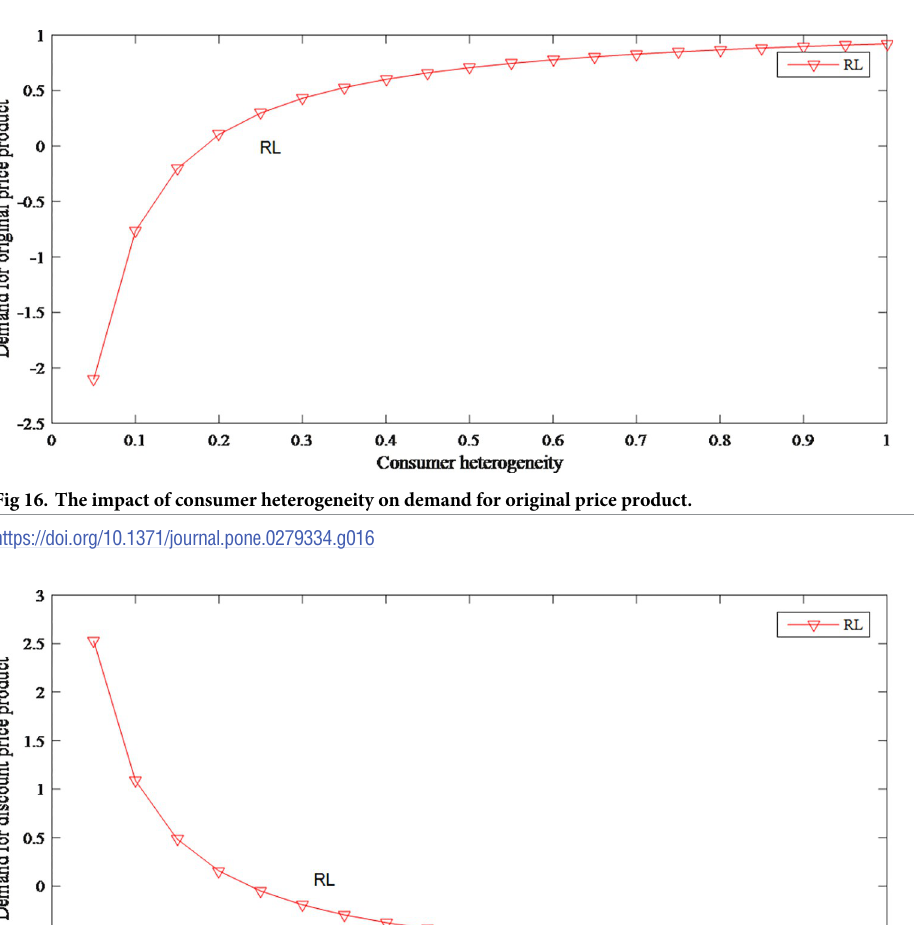
Fig 15. The impact of consumer heterogeneity on wholesale price.